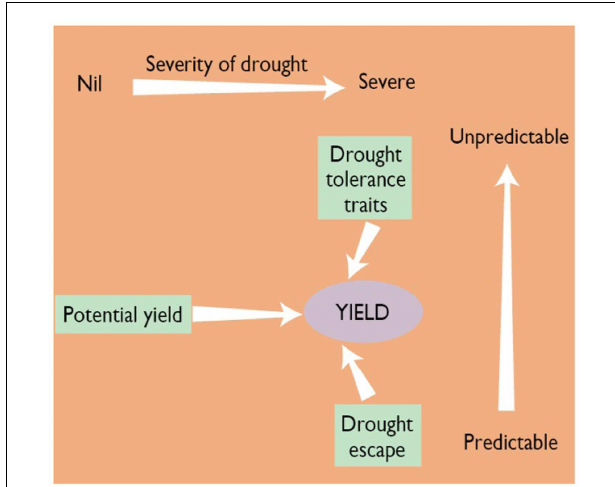
FIGURE 1 | Schematic diagram of three components of yield under drought-prone environments (potential yield, phenology, and drought-tolerance traits) and yield relationship in different types of drought in rain-fed rice. Note that when drought is not present, yield potential determines grain production. Moving to the right in the figure, drought becomes more severe and drought escape or drought tolerance becomes more important.The vertical axis represents the predictability of drought. If drought is very predictable (bottom), drought escape through changing phenology or planting date is a good option. As drought becomes more unpredictable (moving up on the axis), drought-tolerance traits become more necessary (Redrawn from: Fukai and Cooper,